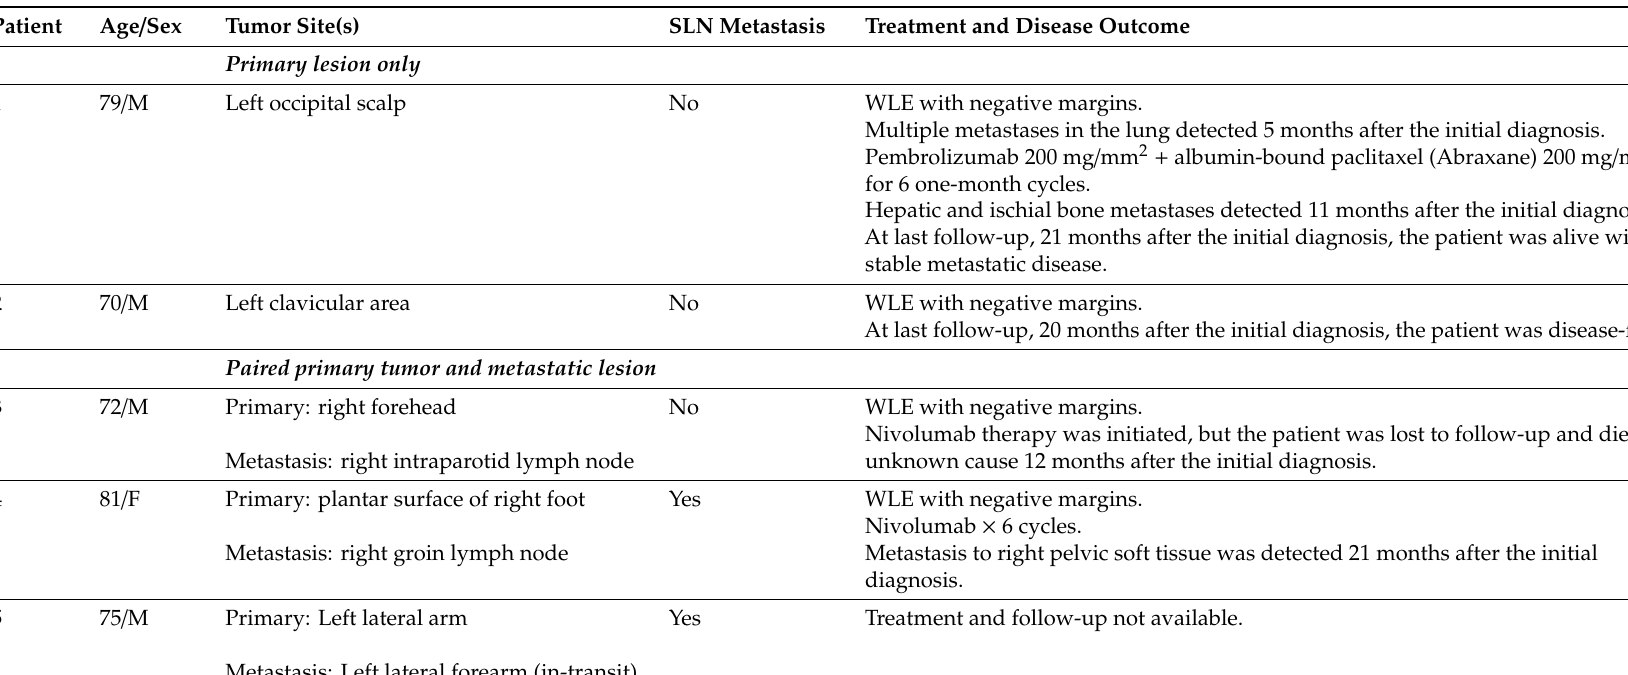
Table 1. Demographic and clinical characteristics of the patients with melanomas analyzed by next-generation sequencing (NGS). Abbreviations: SLN, sentinel lymph node; M, male; WLE, wide local excision; F,